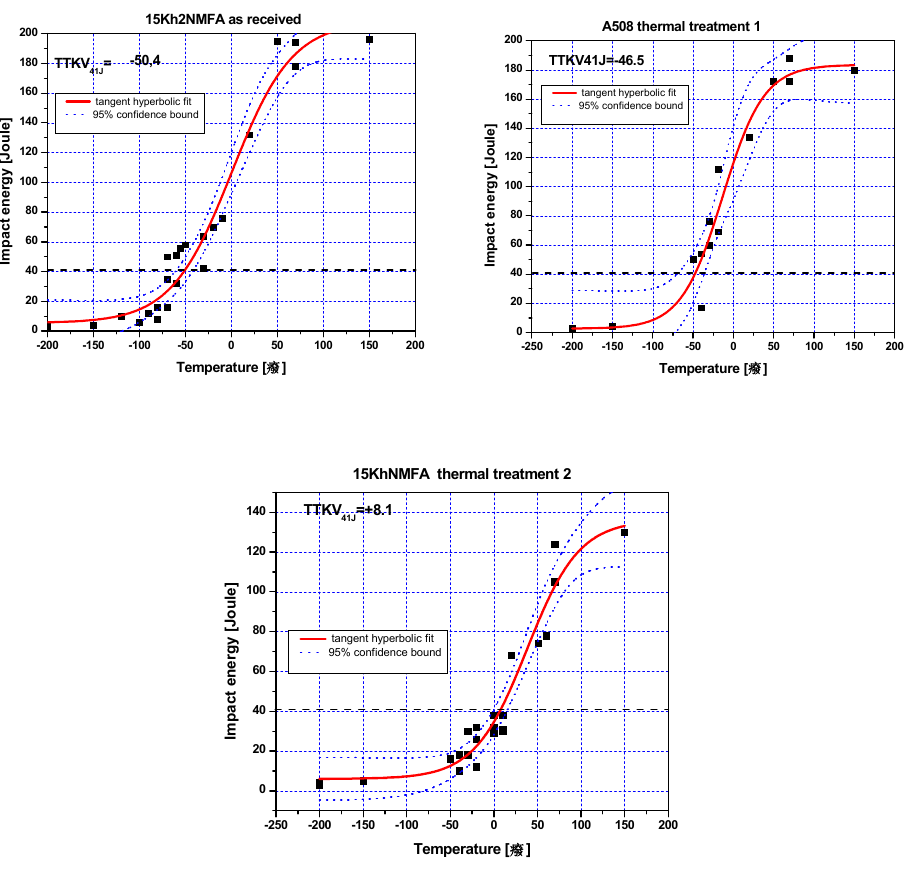
Figure 2. Results of the Charpy impact testing and evaluation of the transition temperature (41J criteria) on 15Kh2NMFA samples as received, and thermally treated. Table 3. Results of Charpy testing of step cooled steel specimens.